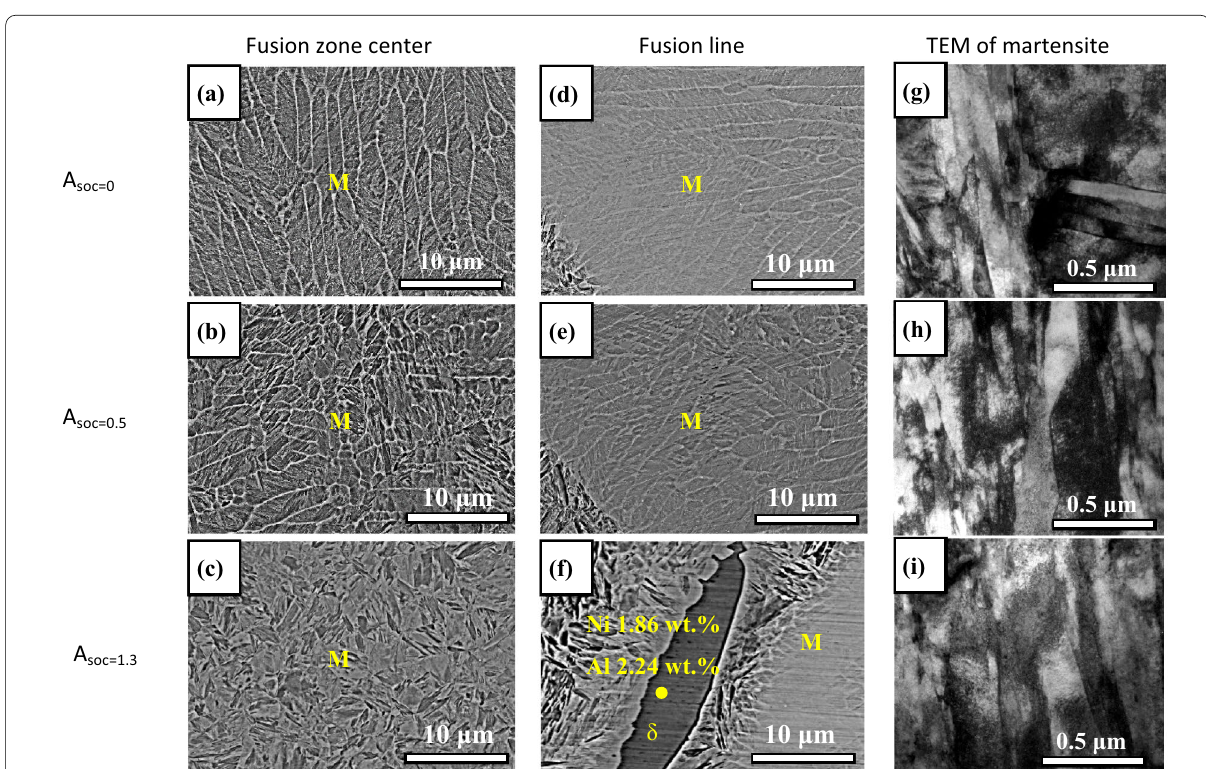
Figure 12 Microstructure in fusion zone and fusion line with different oscillation